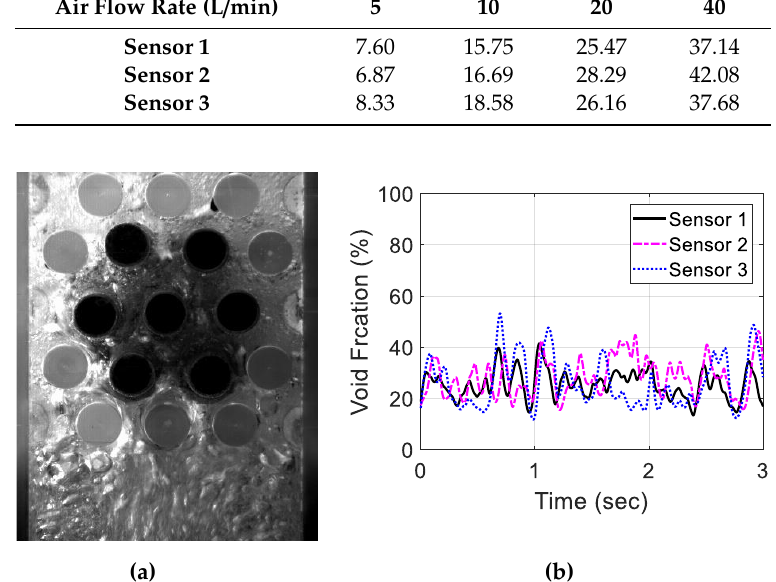
Figure 25. Experimental results for an air flow rate of 20 L/min for the three-sensor configuration: ( a ) flow visualization and ( b ) void fraction signal.